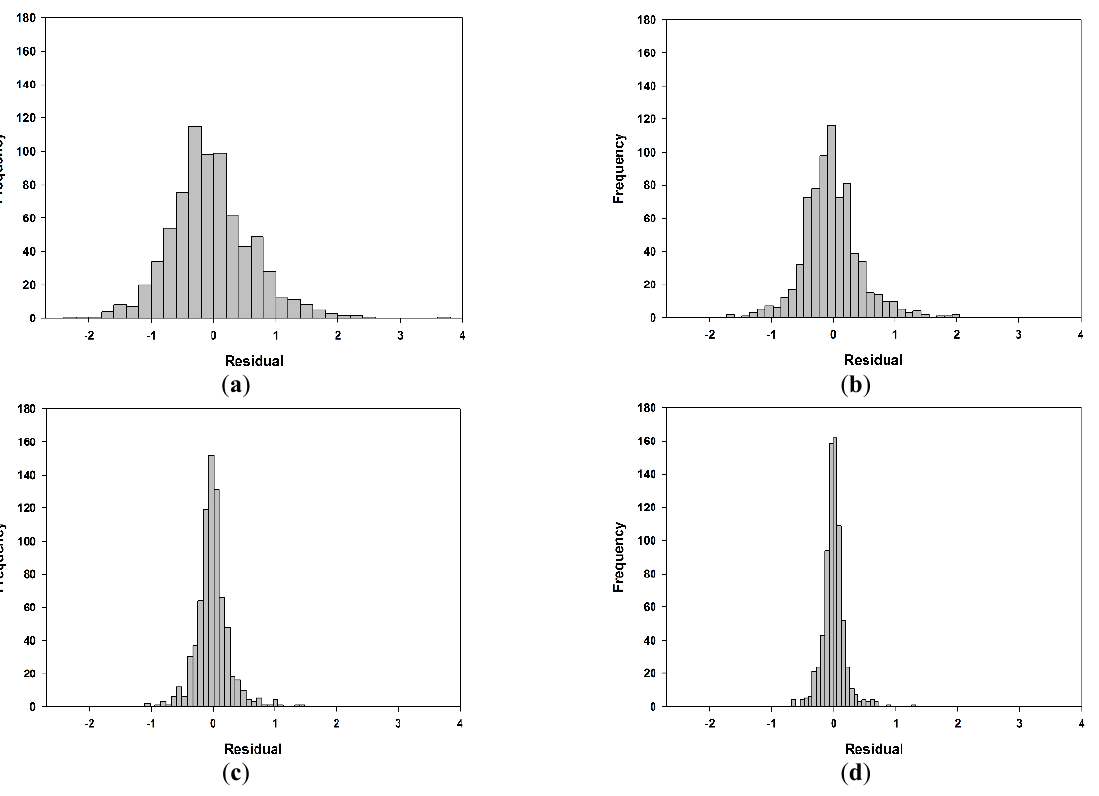
Figure 7. Partial autocorrelation function (PACF) of residuals of Al Ghazalah City as a best-fitted model for data series of standardized precipitation evapotranspiration index (SPEI) at different time scales during the period of 1950–2010: ( a ) 3-SPEI, ( b ) 6-SPEI, ( c ) 12-SPEI and ( d ) 24-SPEI.